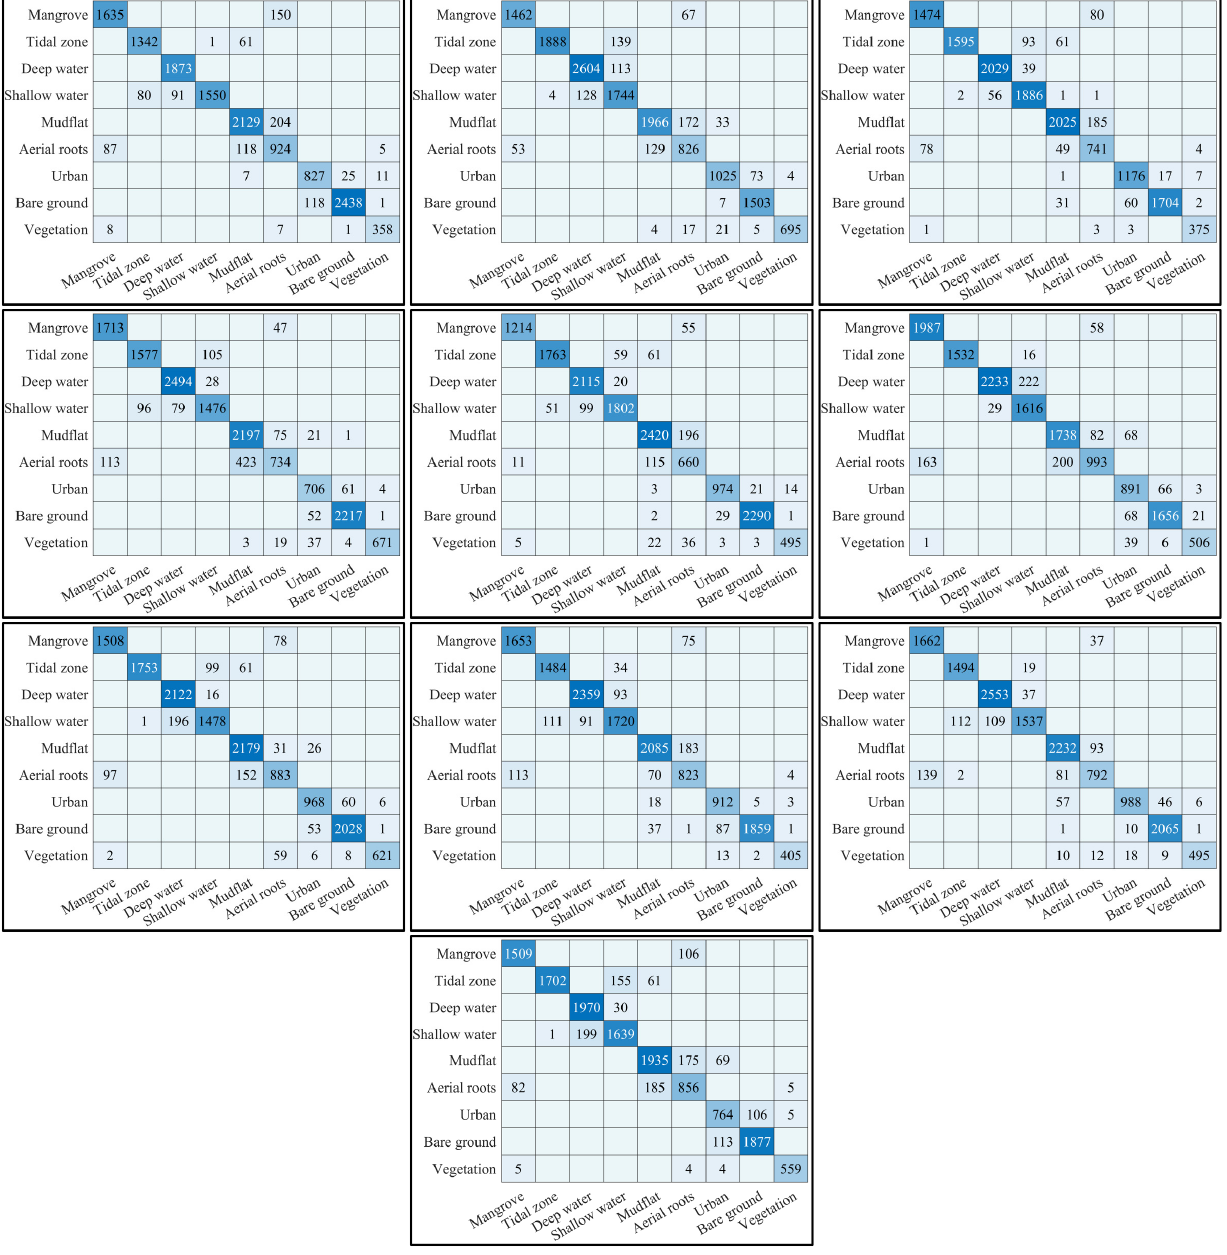
Figure 6. Confusion matrices of mangrove ecosystem maps for ten iterations.